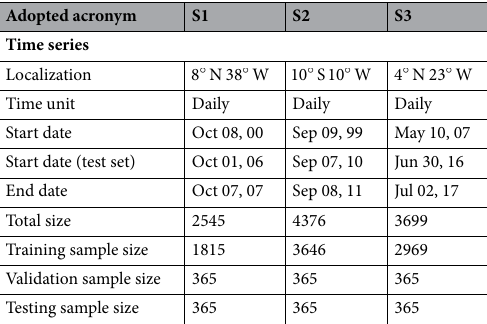
Table 1. Properties of the SST time series used in this work.